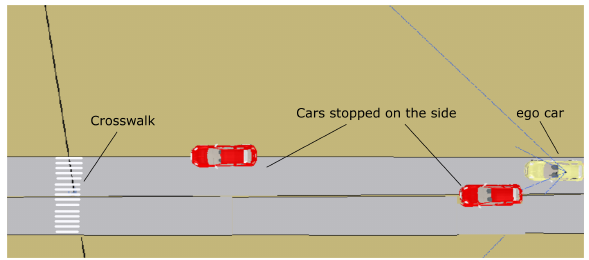
Figure 18. Avoiding obstacles and approaching a crosswalk. The ego car, in yellow, first encounters a couple of obstacles that partially obstruct the lane and then a crosswalk with a pedestrian using it.